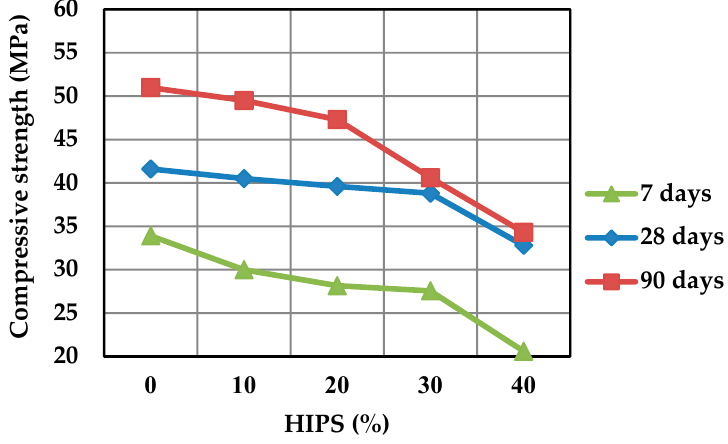
Figure 9. Compressive strength variation with % of HIPS aggregate. 288